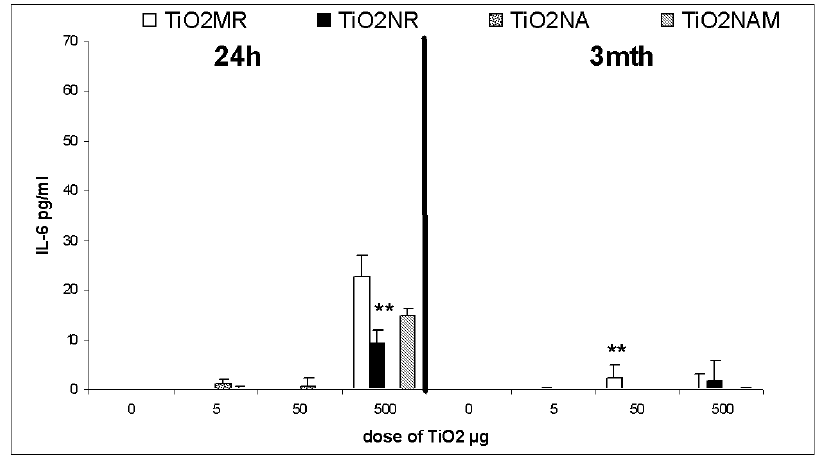
FIGURE 8. TiO - IL-6 in BALF. The levels of IL-6 in BALF are shown as the 2 median and 75 th percentile for micro-size rutile (MR - white), nano-size rutile (NR - black), nano-size anatase (NA - dotted), and nano-size amorphous (NAM - dashed). BALF was collected 24 h or 3 months postinstillation in BALB/c mice. For explanation of statistical test results (**), see Statistics. Each group contained eight